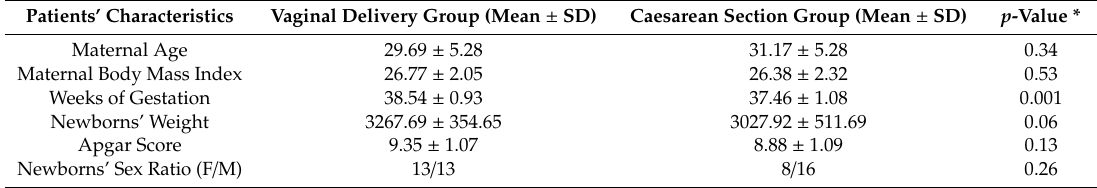
Table 1. Mean and standard deviation (Mean ± SD) of patients’ general characteristics.